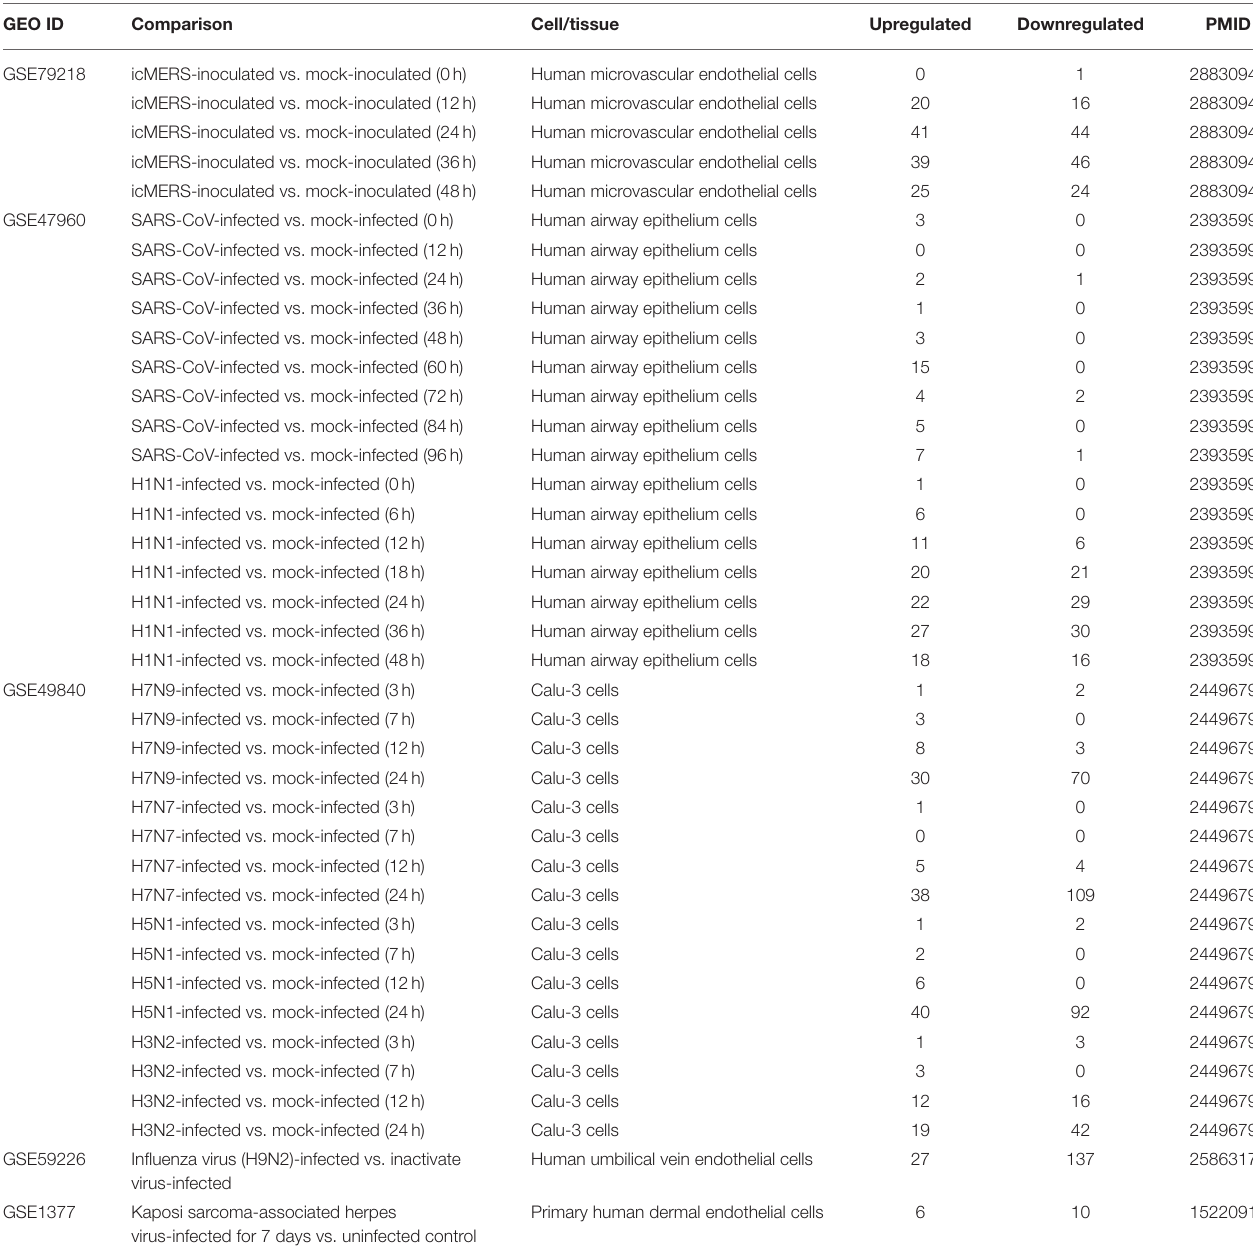
TABLE 3 | Three microarray datasets of time course including MERS coronavirus, SARS coronavirus, avian influenza virus, one dataset of influenza virus infected human umbilical vein endothelial cells and one dataset of Kaposi sarcoma-associated herpes virus infection in the National Institutes of Health (NIH)–National Center for Biotechnology Information (NCBI)–Gene Expression Omnibus (GEO) datasets database (https://www.ncbi.nlm.nih.gov/gds/) were collected to analyze the expression changes of genes that we are interested